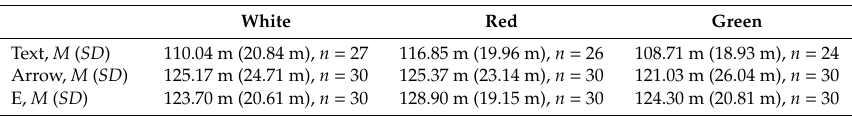
Table 6. Descriptive data giving the distance from which the display content could be identified divided by content type and content